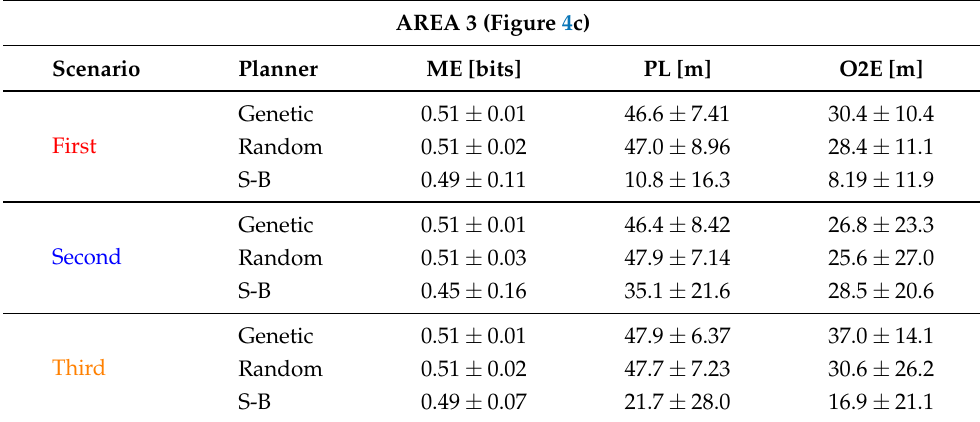
Table 4. Results, in terms of mean and three times the std. dev., of the 3 planners in 3 scenarios of Area 3.